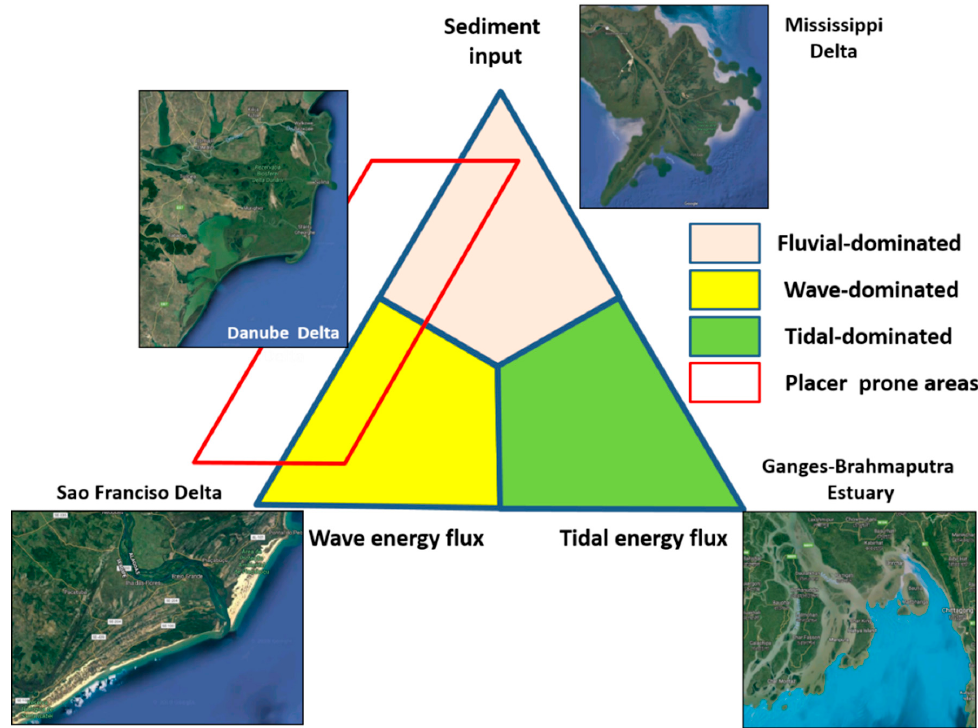
Figure 5. Deltaic placer deposits (area framed by the red line) as a function of wave energy flux, tidal energy flux and sediment supply. Satellite images (source: Google Maps) have been introduced to show the various landform of wave, tidal, and fluvial-dominated deltas. The mixed fluvial to wave-dominated delta of the River Danube has been selected as reference type for mixed-type wave-fluvial-dominated deltaic placer deposits because of its widespread heavy mineral concentration, among others garnet and tourmaline.